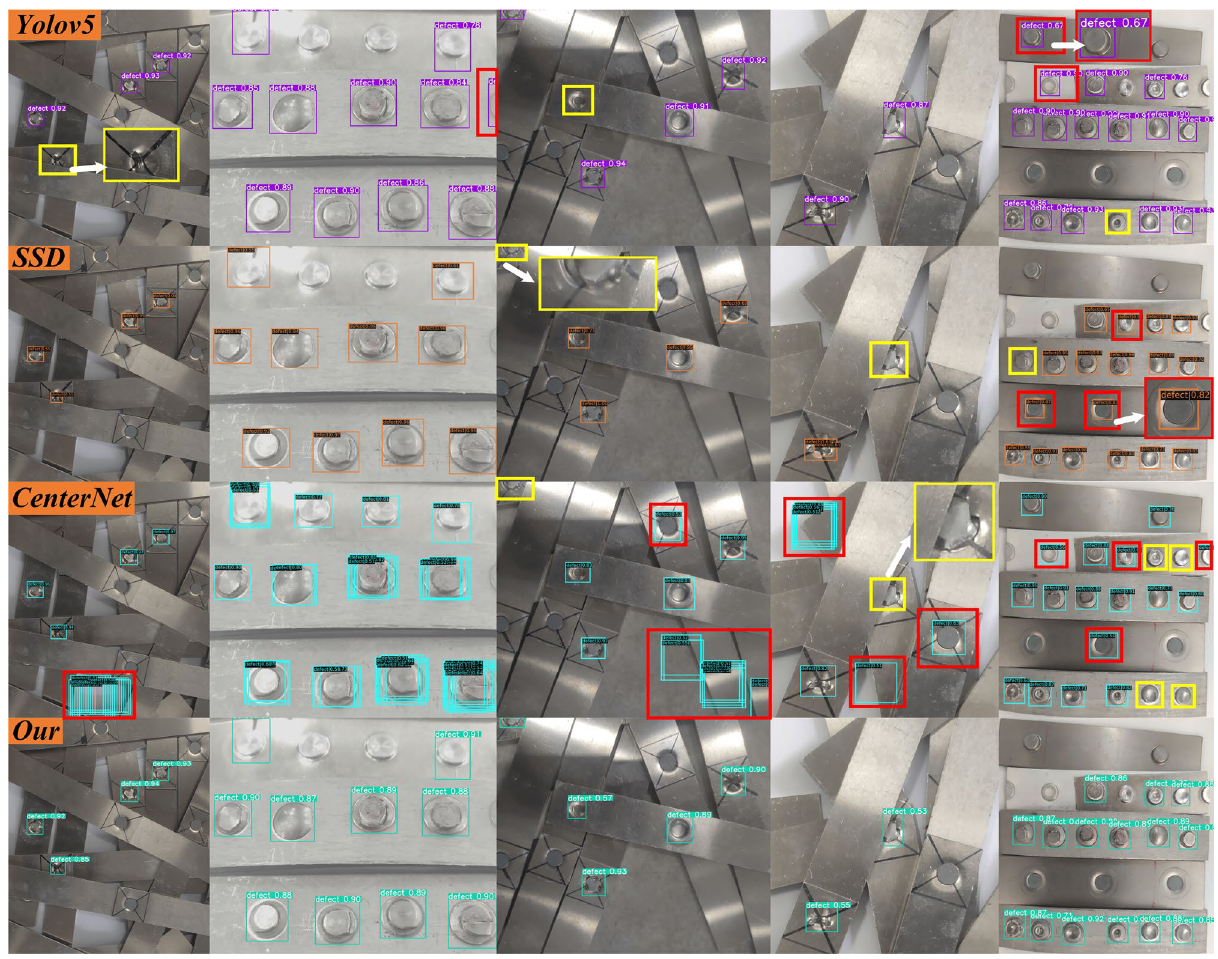
Figure 15. Qualitative comparison of different algorithms. Each row represents the detection results of one algorithm, from top to bottom, Yolov5, SSD, CenterNet, and Our. Missed and incorrectly detected objects are marked with yellow and red rectangular boxes,